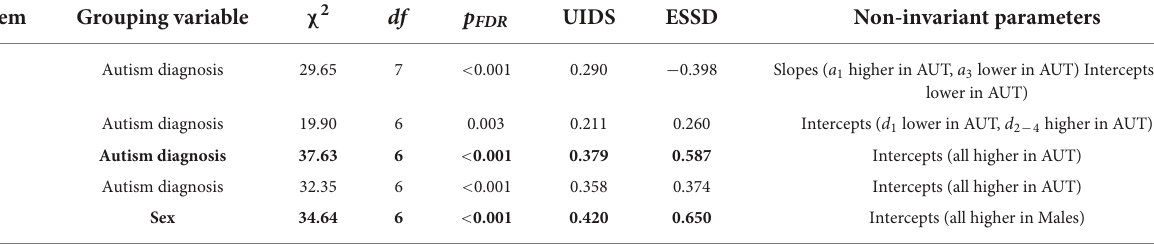
TABLE 6 Differential item functioning test results for non-invariant items.